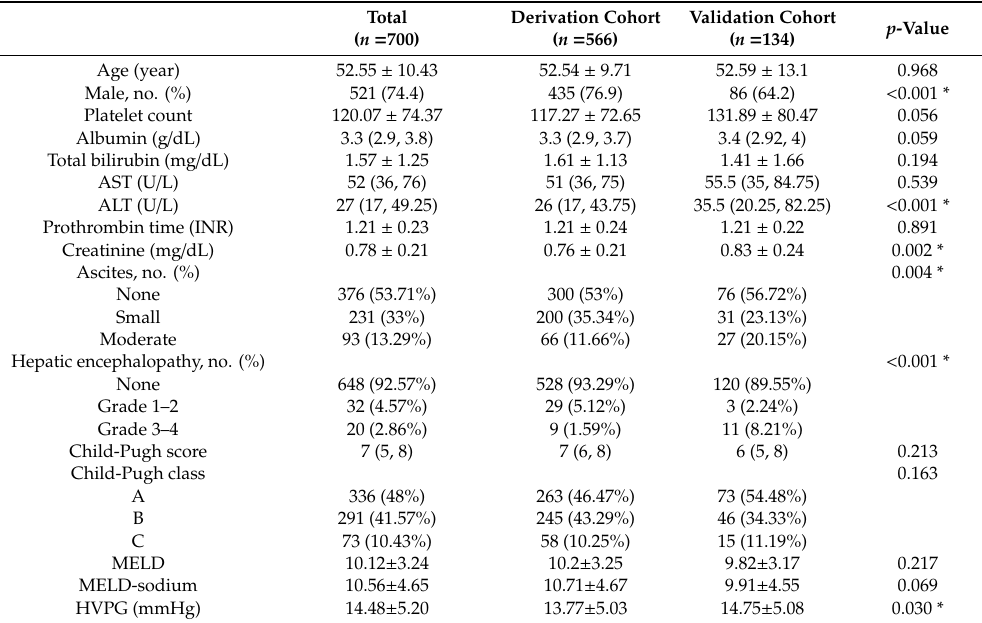
Table 1. Baseline characteristics of the overall study